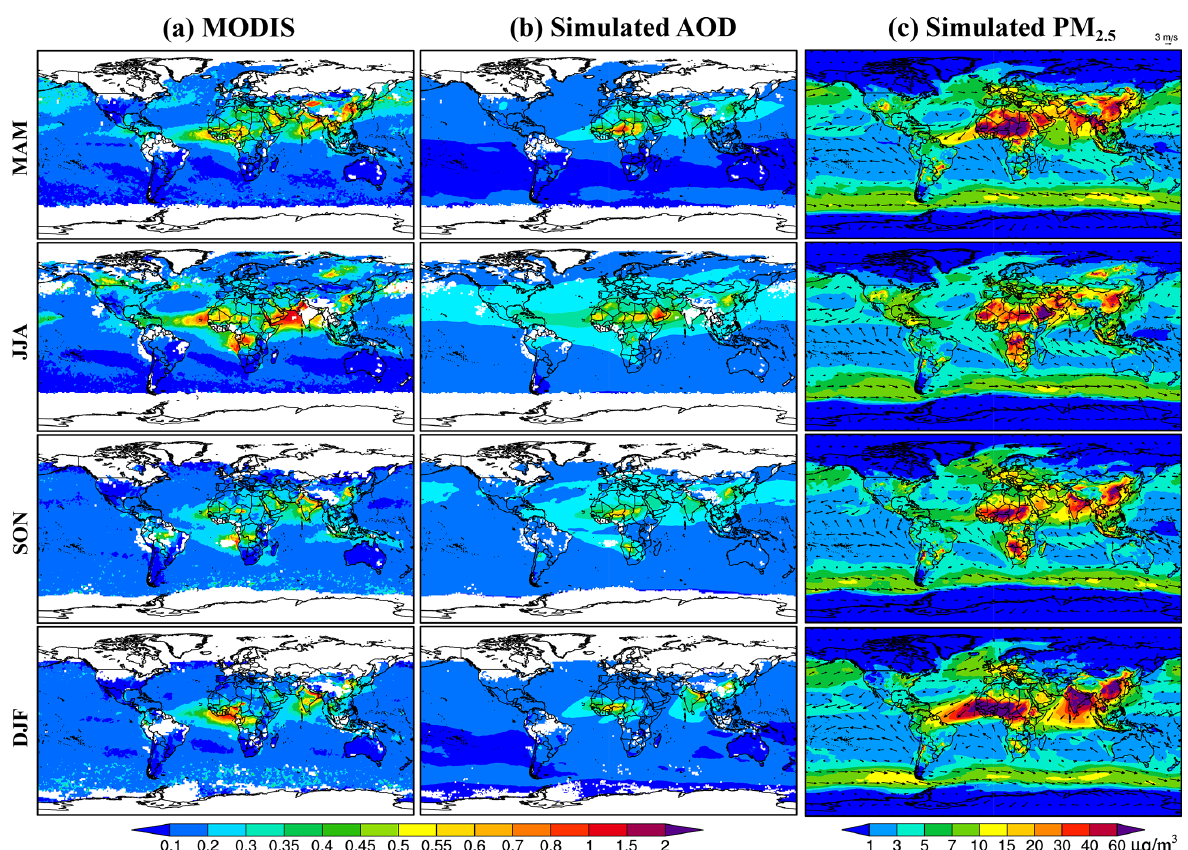
Figure 5. Spatial distributions of seasonal mean AOD at 550nm from (a) MODIS data and (b) GNAQPMS averaged in 2018 and (c) PM 2 . 5 in